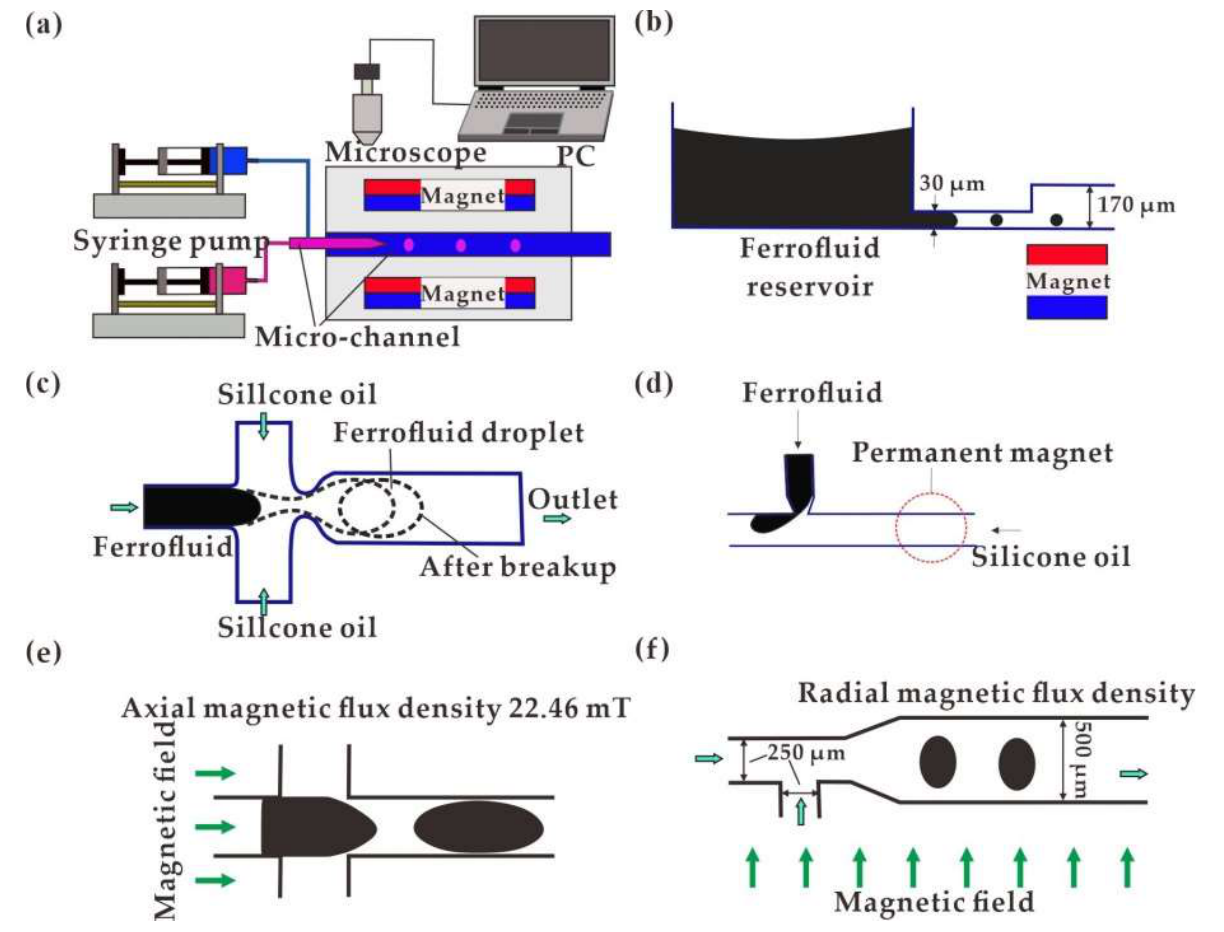
Figure 1. Ferrofluid droplet generation devices: ( a ) Straight channels with permanent magnetic field [80]; ( b ) Driven by a permanent magnet without a pump [81]; ( c ) In cross-shaped channel with a perpendicular uniform magnetic field [88]; ( d ) In T-shaped microfluidic chip with a permanent magnet [84]; ( e ) Horizontal magnetic field [90]; ( f ) Radial magnetic field [91].